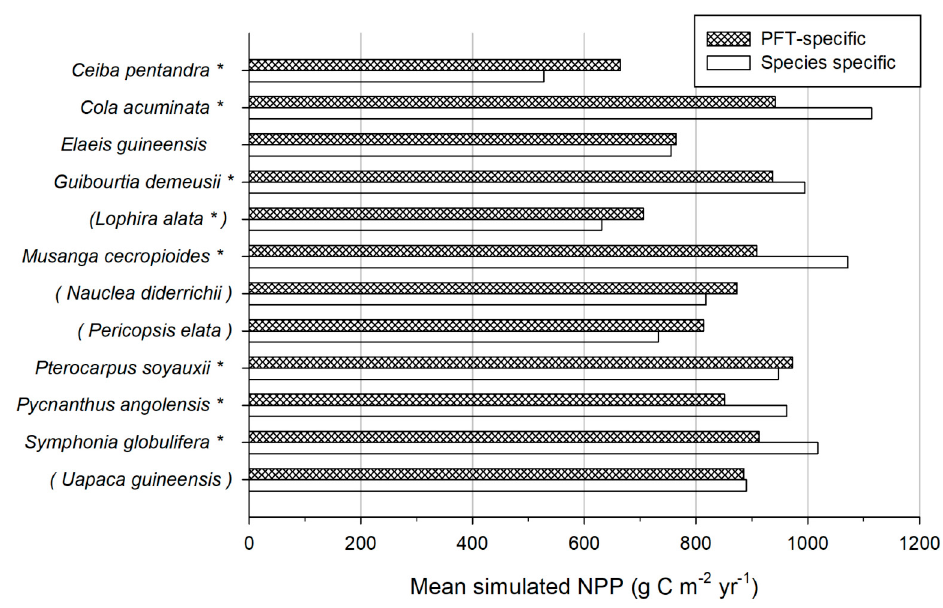
Figure 1. Bar chart of the mean simulated net primary productivity (NPP, g C m − 2 yr − 1 ) over the observed points of species occurrence, obtained with CRU (Climatic Research Unit) historical climatic data for the reference 1980–1999 period, using respectively PFT- (hatched bars) and species-specific (white bars) morpho-physiological traits (see Table 2). An asterisk behind species name indicates a significant difference ( p -value of the Wilcoxon paired t -test < 0.01) between NPP values. Species name between brackets indicates that only height trait has been adjusted.